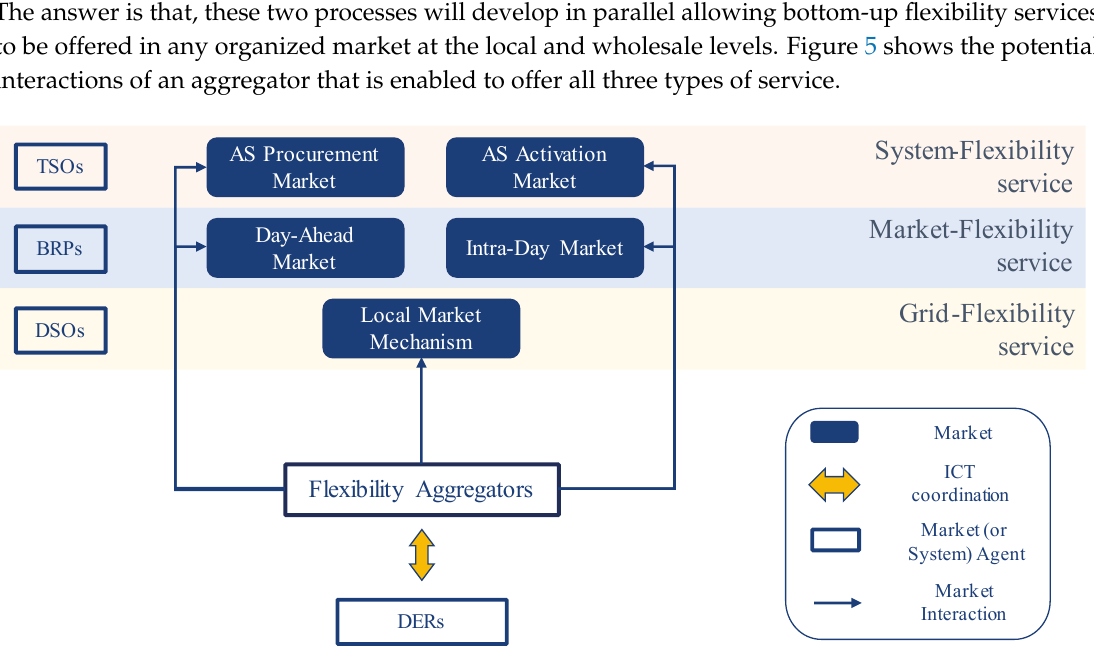
Figure 5. Second stage: The aggregator can also provide grid services since the Distribution System Operator (DSO) will be able to contract services with market parties for managing the